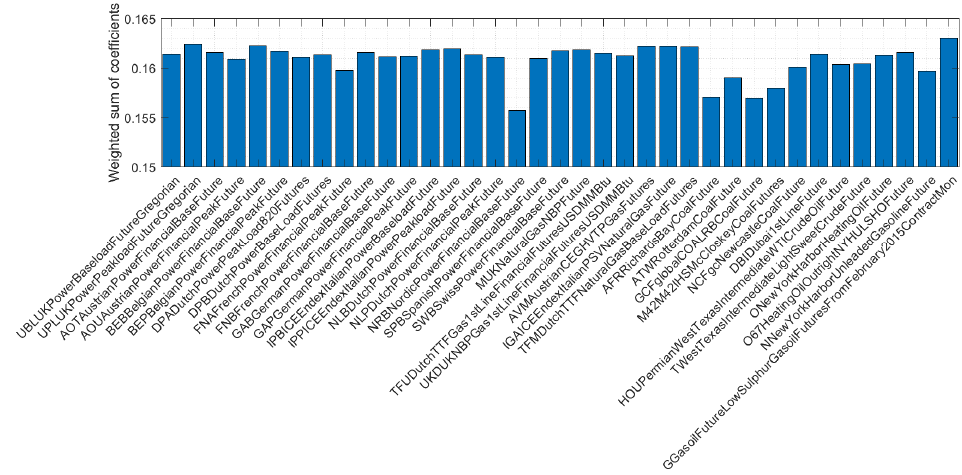
Figure 8. The participation of indicators in total variance for